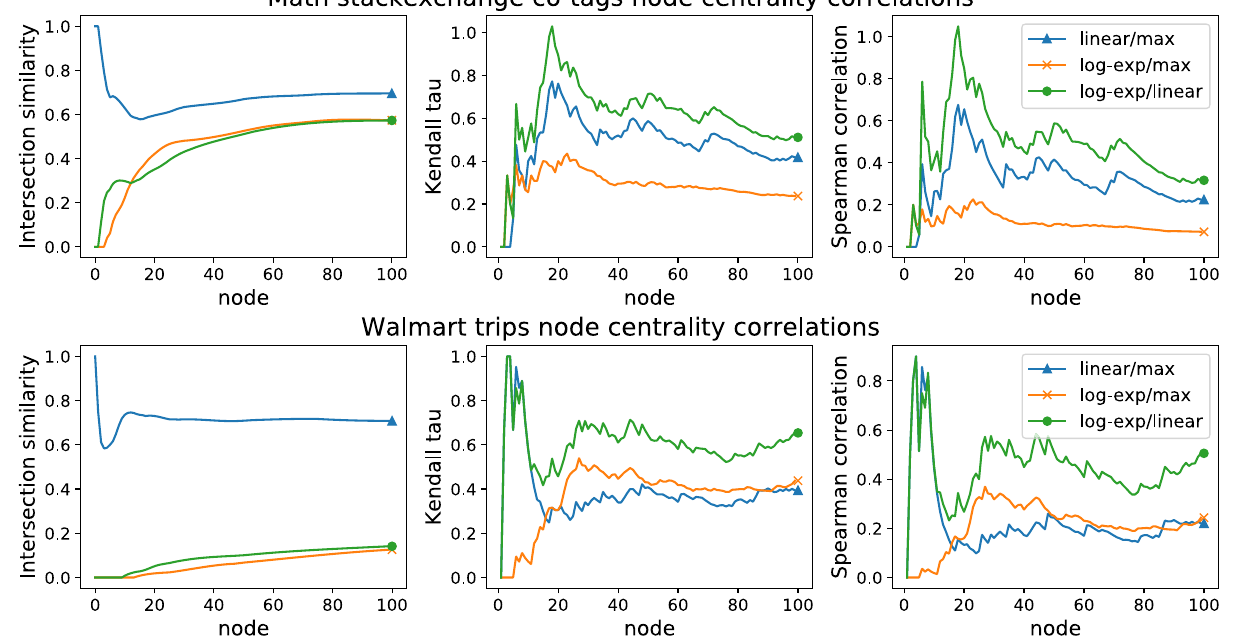
Fig. 3 Similarity between the node and edge centralities. Intersection similarity, Kendall- τ correlation, and Spearman correlation similarities between top k nodes, for k ∈ {1, … , 100}, on the Math stackexchange co-tags and the Walmart trips hypergraph datasets. Nodes are ranked according to the "linear'', "log- exp'', and "max'' centrality models and are paired as speci fi ed in the legend.